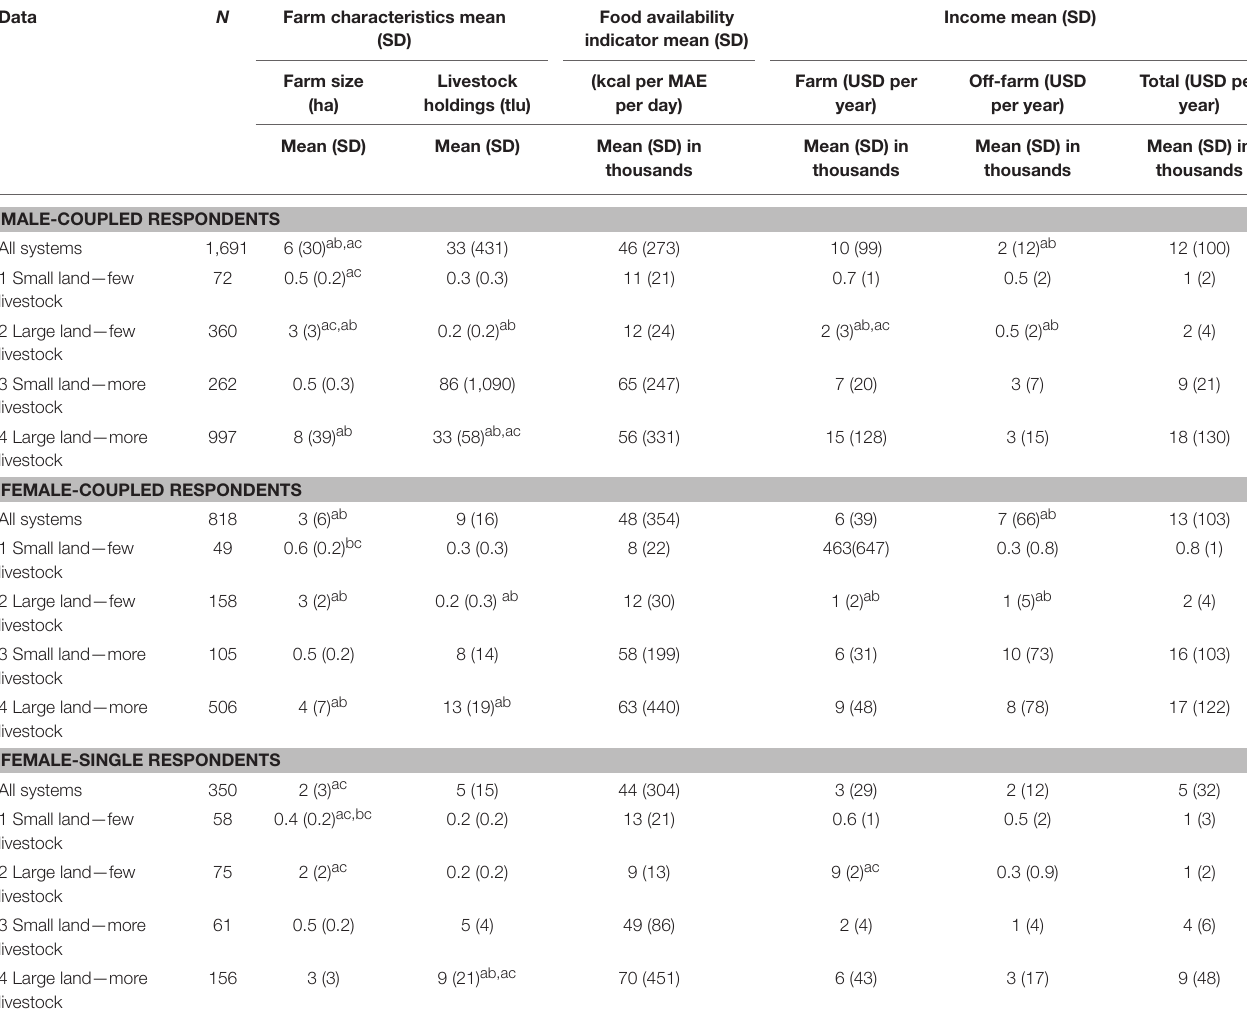
TABLE 3 | Inferential statistics of farm characteristics, food availability, and income by respondent and system type.